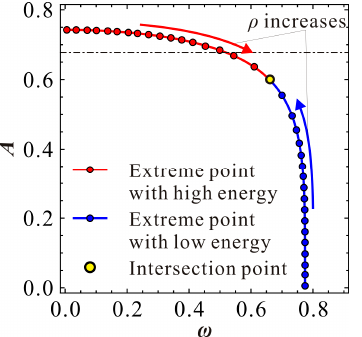
Figure 2. Variations of the extreme point as the increase of nondimensional AC excitation amplitude ρ for α = 0.8, γ = 0.1, µ = 0.005 and δ =